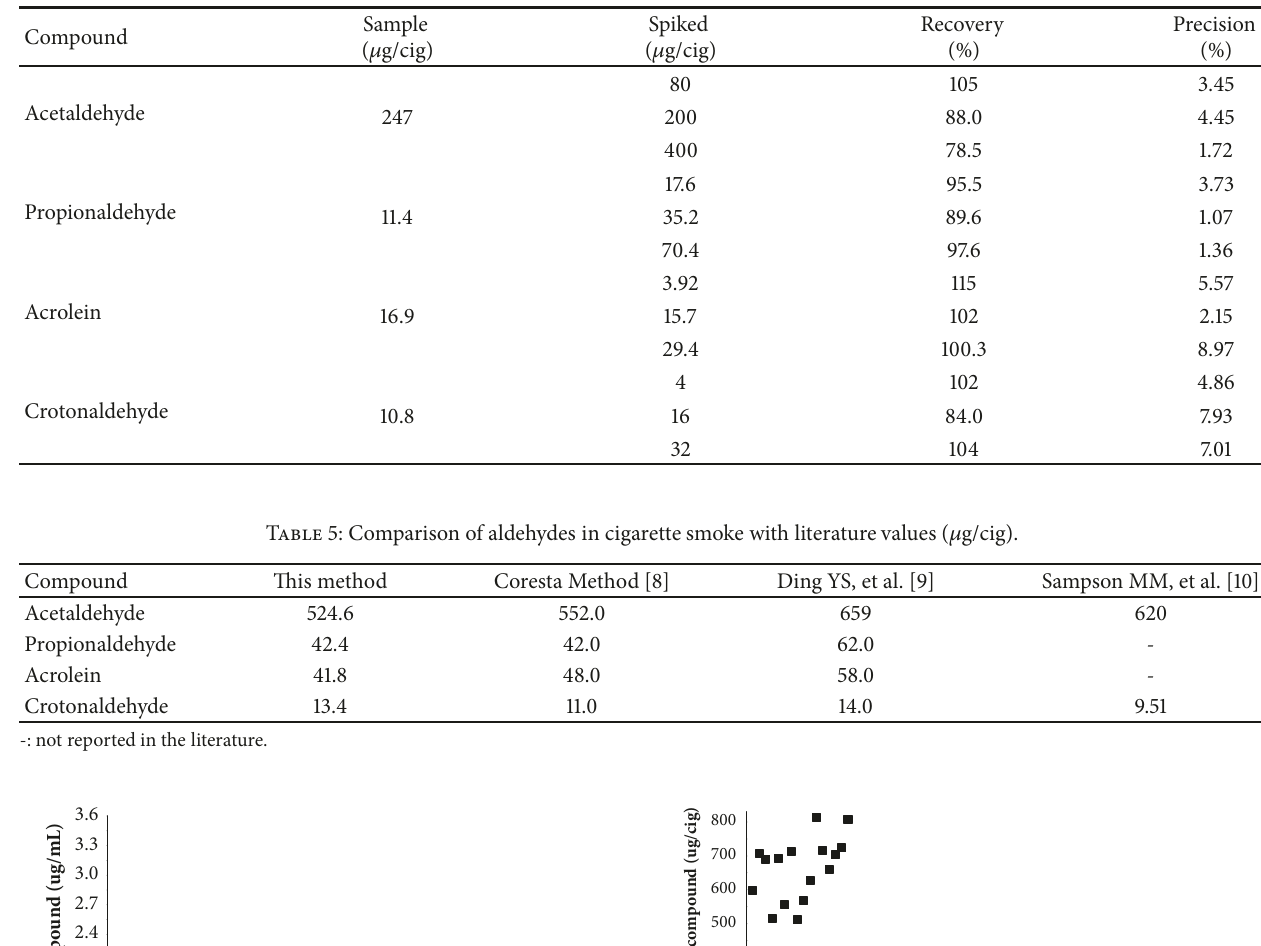
Table 4: The recoveries and precisions ( RSDs ) of acetaldehyde, propionaldehyde, acrolein, and crotonaldehyde ( n =6).